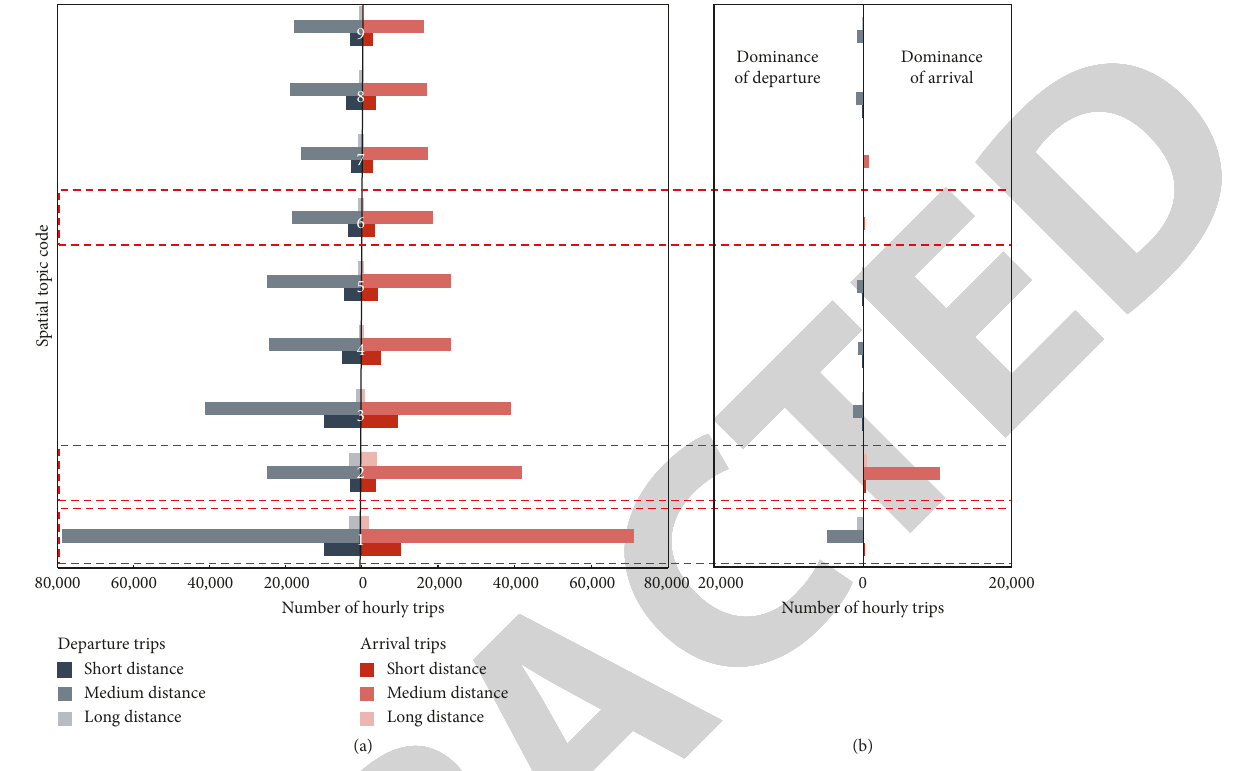
Figure 3: Distribution of spatial topics of car-hailing mobility patterns. (a) Spatial word distribution. (b) Difference between hourly departure and arrival